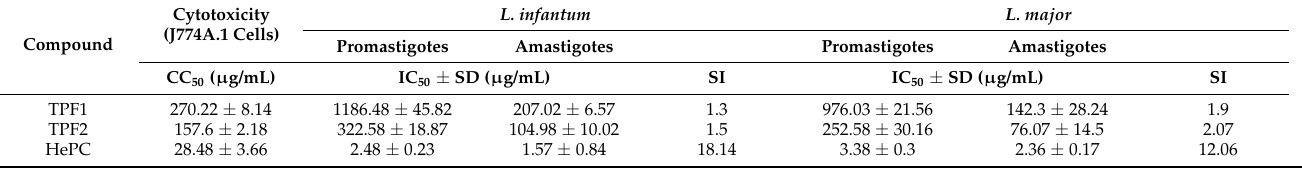
Figure 2. Anti-promastigote effect of TPF1 and TPF2 against L. infantum and L. major promastigotes. Log-phase promastigotes were treated with TPF1 ( A ) and TPF2 ( B ) at various increasing concen- trations for 72 h and their viability was determined using the resazurin cell viability assay. OD was determined with a microplate spectrophotometer at 570 nm (reference filter 630 nm). Data are presented as mean values ± SD of three independent experiments. Cytotoxicity evaluation and anti-leishmanial activity of individual drugs against Leishmania infantum and Leishmania major promastigotes and intracellular